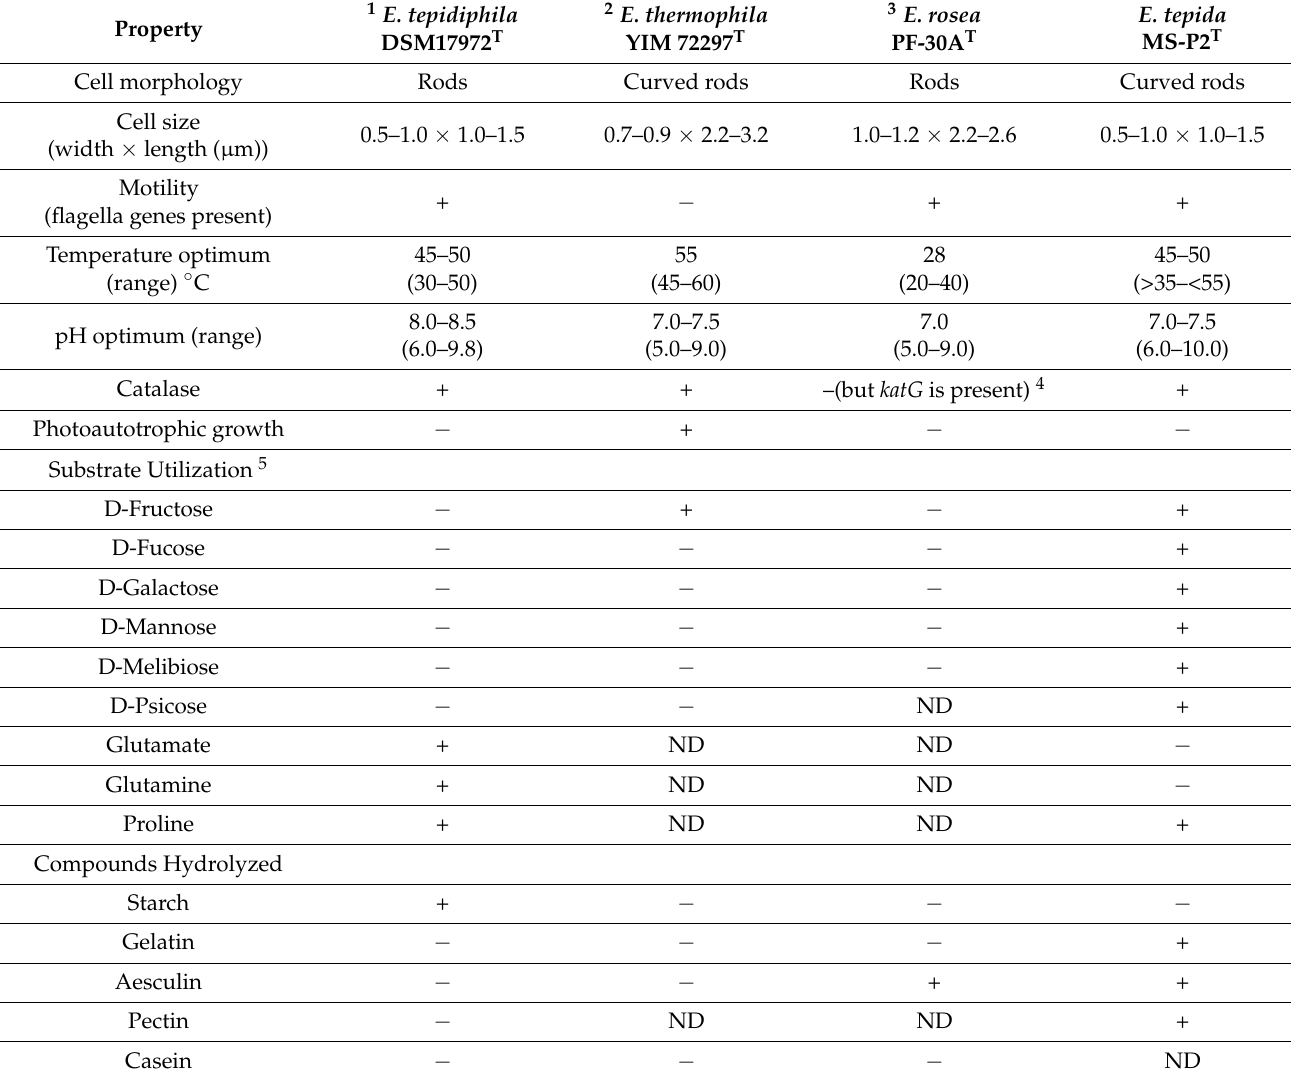
Table 1. Differential characteristics of species in the genus Elioraea . Positive [+], negative [ − ], not determined [ND]. All species can synthesize bacteriochlorophyll a and carotenoids, are pink in color, are positive for cytochrome c oxidase, and employ ubiquinone-10 as the major respiratory